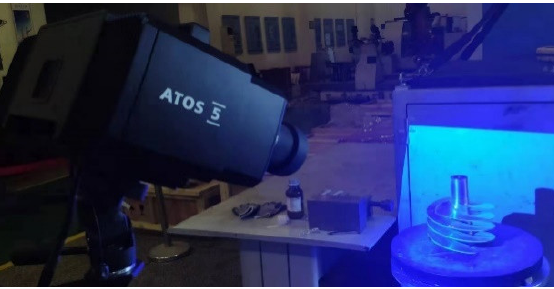
Figure 9. Machining accuracy measurement.